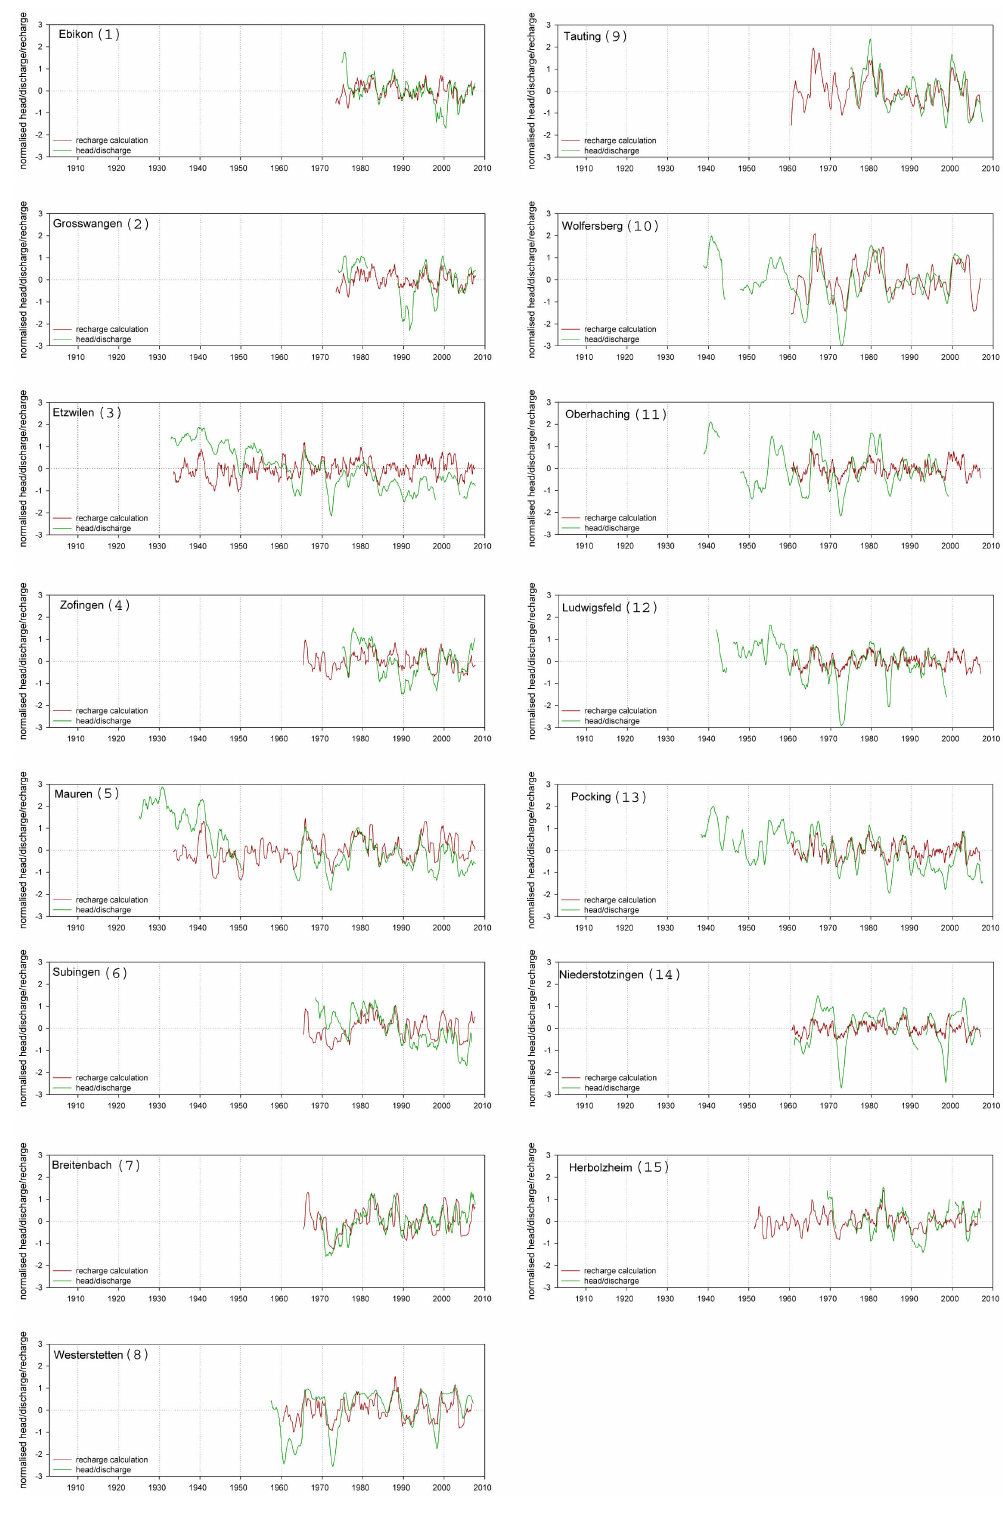
Fig. 2. Normalised monthly observed head data versus calculated recharge for the different groundwater sites over periods of varying length between 1930 and